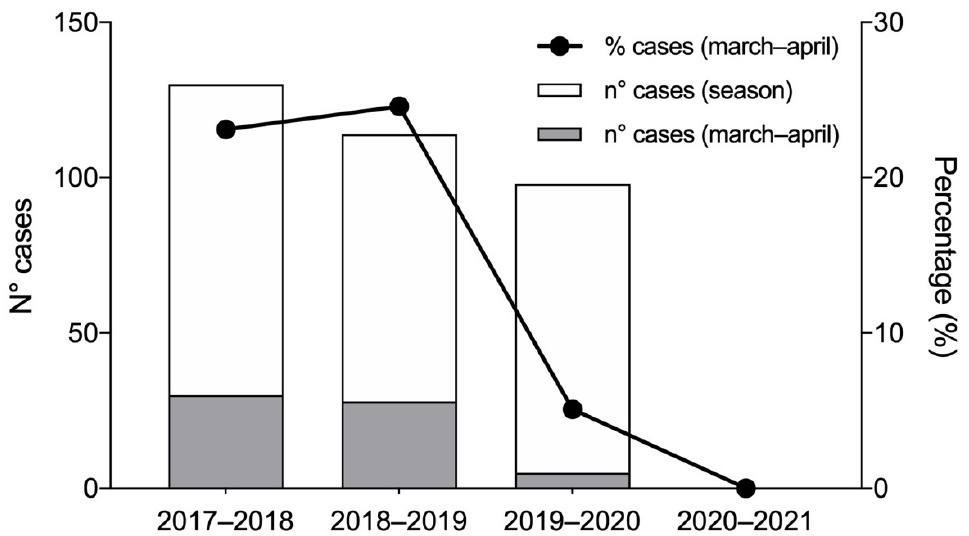
Figure 1. Severe drop in hospitalizations for bronchiolitis during March–April 2020 (5.1%, 5/98) as compared with 2019 (24.6%; 28/114) and 2018 (23.1%; 30/130), p < 0.001. No patients with bronchiolitis were hospitalized during the entire 2020–2021 (0) epidemic season.